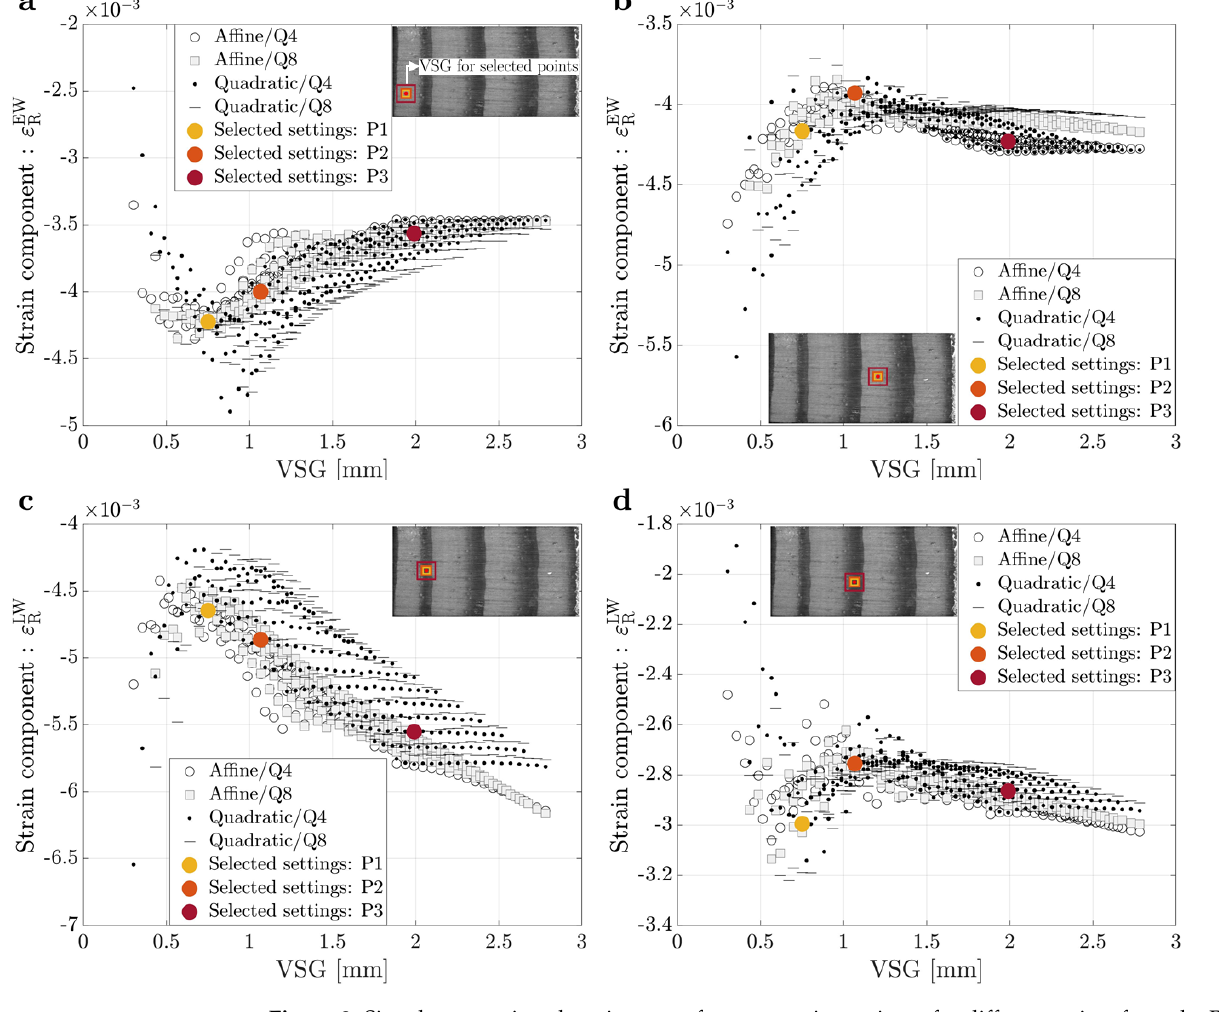
Figure 3. Signal versus virtual strain gauge for an on-axis specimen for different points from the ROI: ( a ) Small earlywood (EW) tissue; ( b ) Large earlywood (EW) tissue; ( c ) Small latewood (LW) tissue and ( d ) Large latewood (LW)